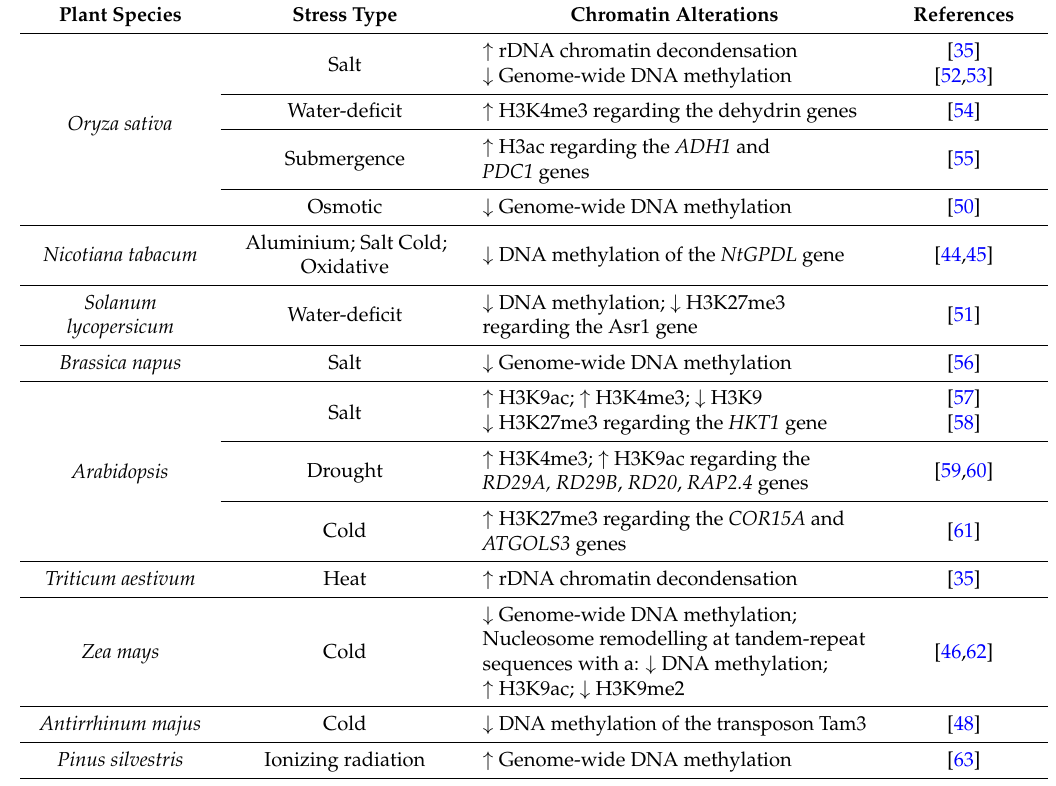
Table 1. Some examples of chromatin flexibility in relation to abiotic stress